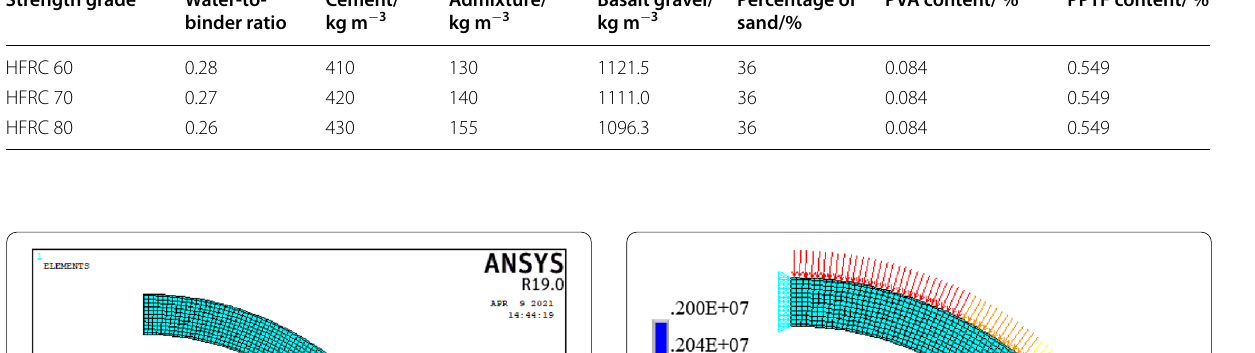
Table 3 Mix ratio of hybrid-fiber-reinforced concrete. Strength grade